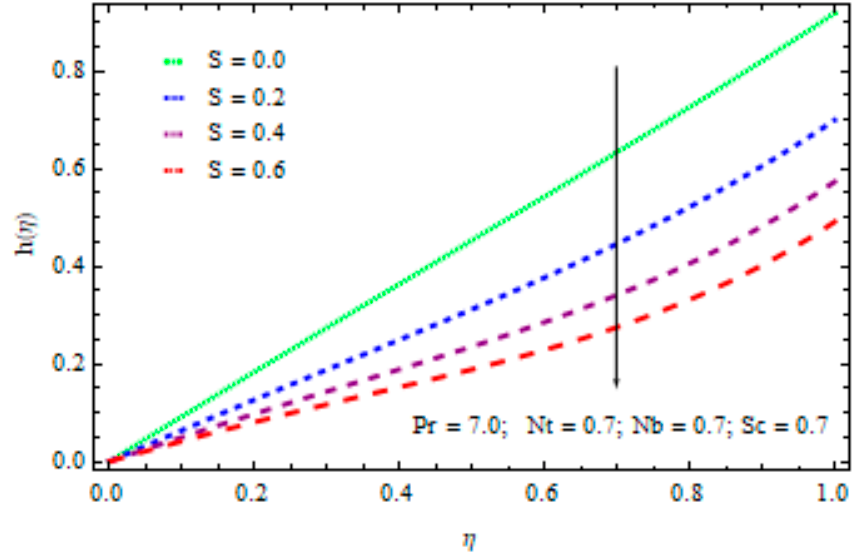
Figure 11. The impact of the unsteady parameter S on the draining flow in the x-direction.